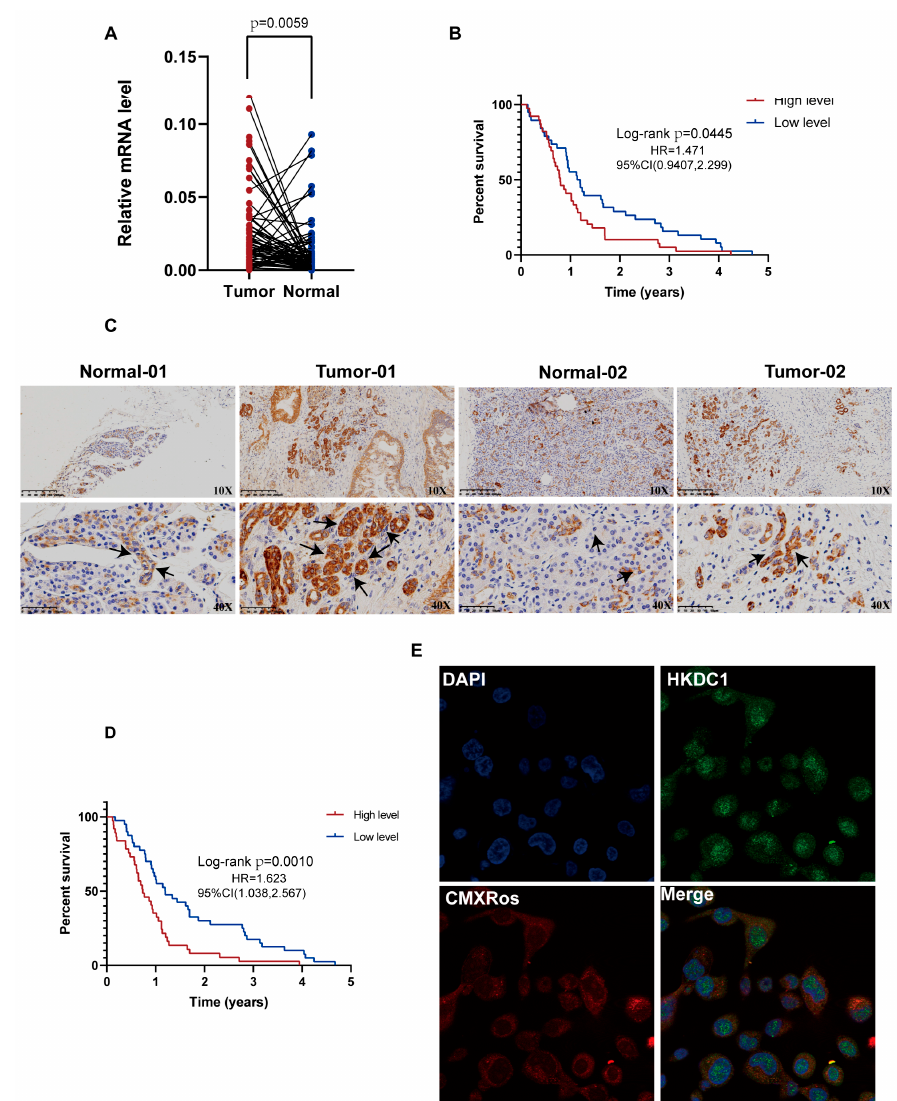
Figure 10. External expression validation of the selected mitochondrial gene, HKDC1. ( A ) The comparison of HKDC1 mRNA levels measured by qRT-PCR between 77 paired PC tumor tissues and normal tissues adjacent to cancer from our FUSCC cohort. ( B ) The Kaplan–Meier analysis of OS in different groups classified by the median value of HKDC1 mRNA levels in FUSCC cohort. ( C ) Representative microphotographs of HKDC1 staining in tumor (arrow) and matched adjacent normal tissues (arrowhead). ( D ) Survival analyses for OS of patients from FUSCC cohort with different HKDC1 expression levels in the tumor. ( E ) Immunofluorescence colocalization indicated that HKDC1 localized to